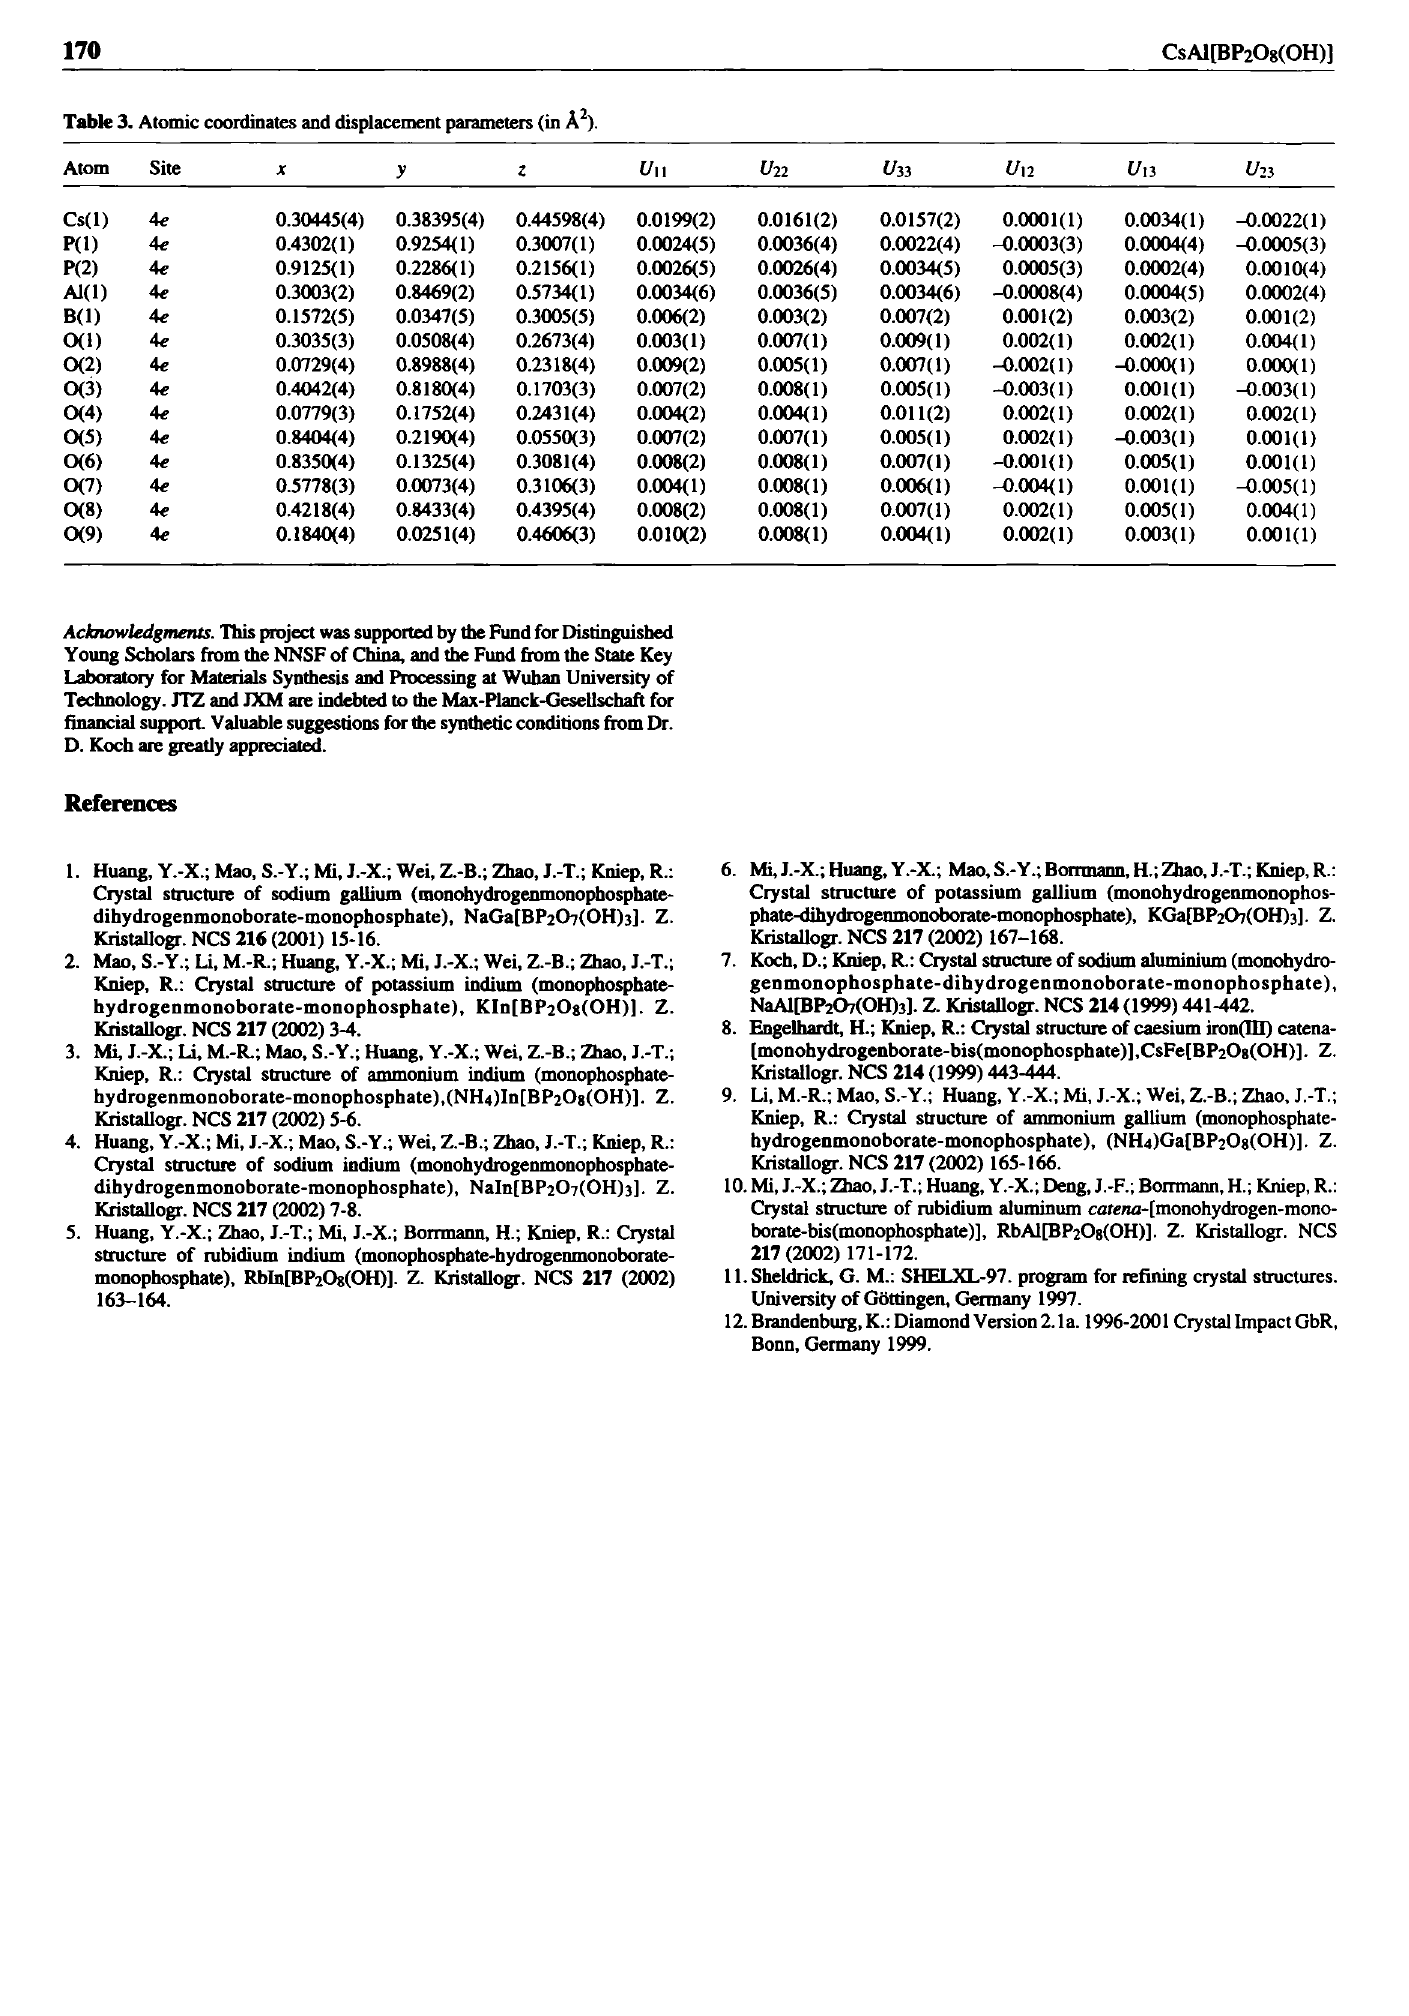
Table 3. Atomic coordinates and displacement parameters (in À 2